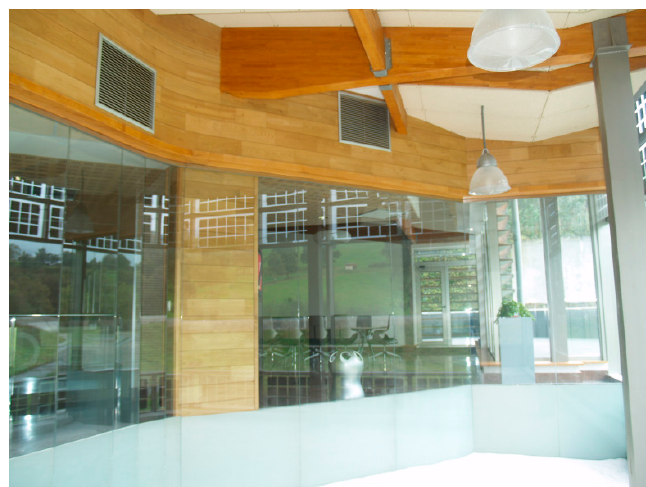
Figure 3. Interior wall (partially glazed) in the attached sunspace.